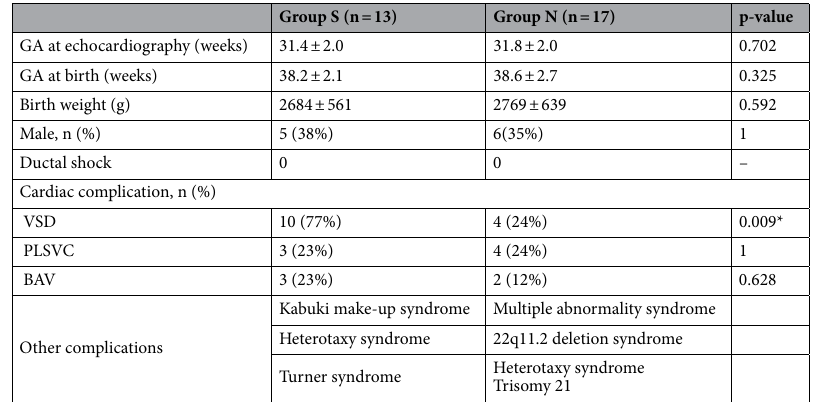
Table 1. Patient and clinical characteristics of each group patients (n = 30). GA gestational age, VSD ventricular septal defect, PLSVC persistent left superior vena cava,; BAV bicuspid aortic valve. * p < 0.05 between group S and group N.